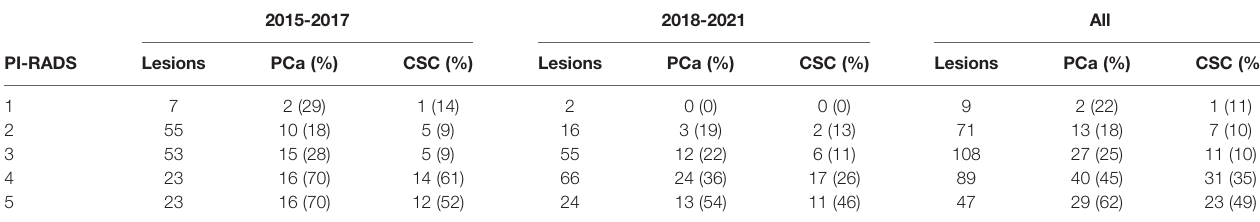
TABLE 1 | Occurrence of any prostate cancer and clinically signi fi cant prostate cancer in MRI-fusion guided biopsy targets strati fi ed by PI-RADS score and year of